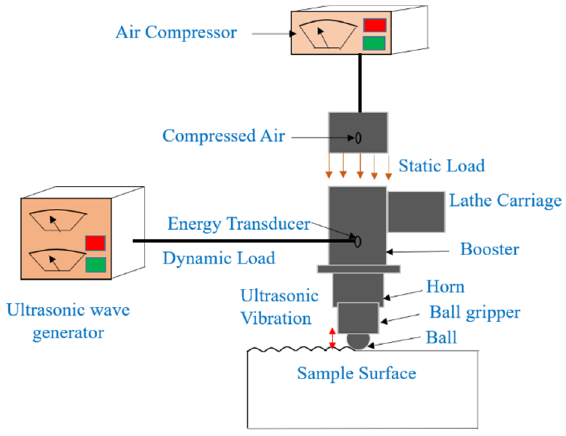
Figure 1. Schematic of UNSM